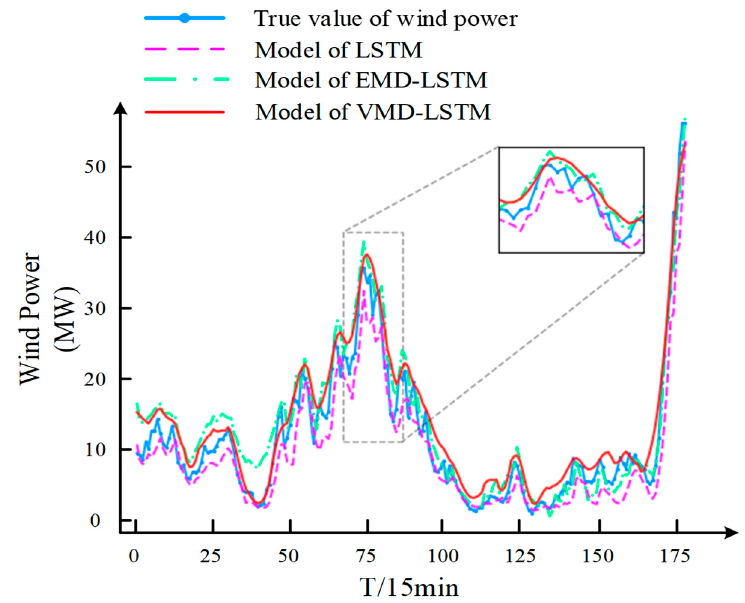
Figure 7. Predicted and real values for different decomposition models.